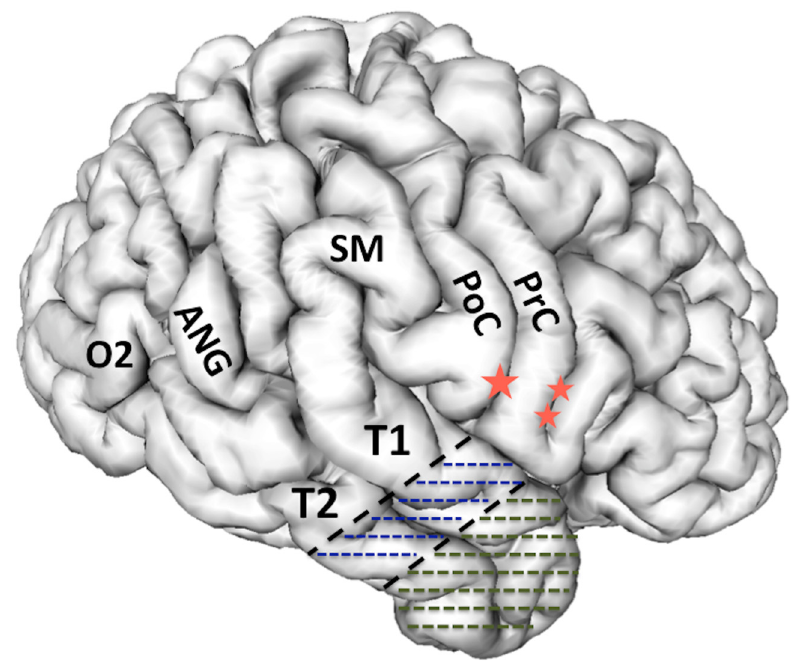
Figure 1. 3-D reconstruction of the non-dominant right hemisphere. The dashed line illustrates the anatomical resection approach of cortico-amygdalohippocampectomy. In the non-dominant hemisphere, the resection is taken posteriorly to the level of the central sulcus along T1. In the dominant hemisphere, the T1 resection is no further posterior than the precentral sulcus in order to respect and preserve posterior language areas. Single star = central sulcus, double star = pre-central sulcus, T1 = superior temporal gyrus, T2 = middle temporal gyrus, PoC = post central gyrus, PrC = precentral gyrus, SM = supramarginal gyrus, ANG = angular gyrus, O2 = second occipital gyrus, which is the gyral continuum of T2 in the occipital lobe.